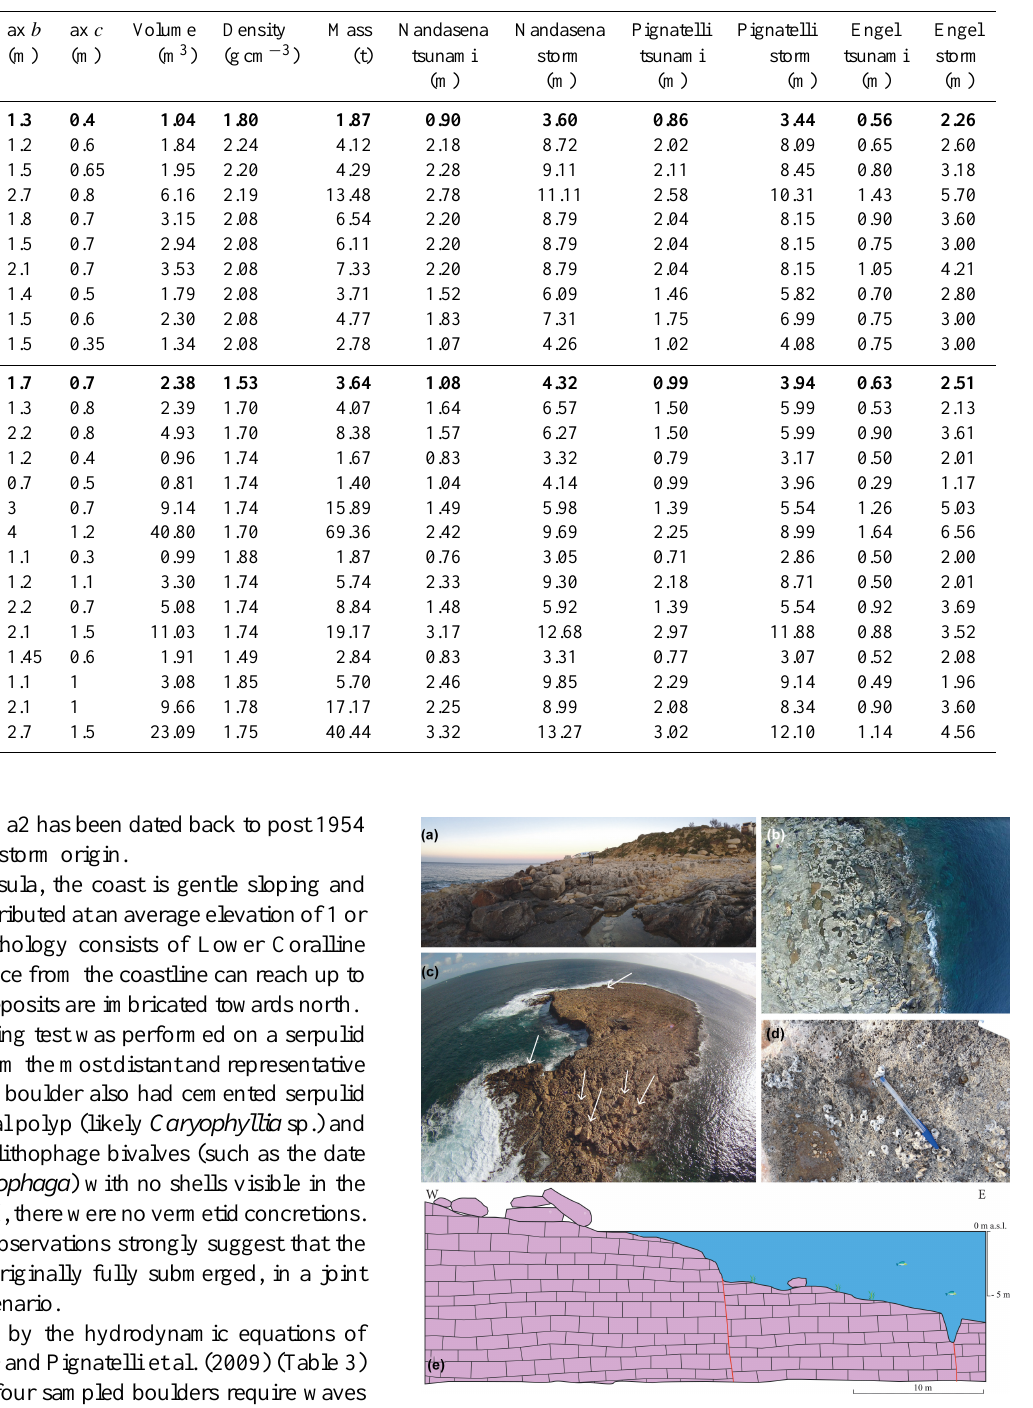
Figure 4. (a) Boulder deposit at Bu˙gibba; (b) view of the deposit from UAV; (c) view of Qawra peninsula from UAV; (d) vermetid shells; (e) reconstruction of the submerged